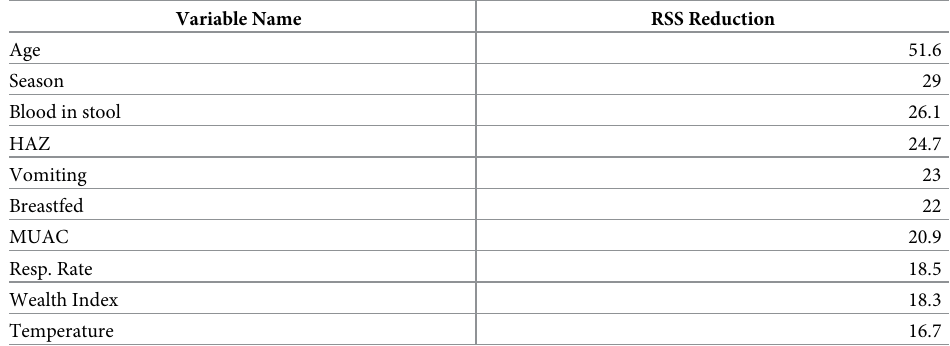
Table 2. Rank of variable importance for prediction of viral etiology by reduction in residual sum of squares (RSS) using random forest regression.